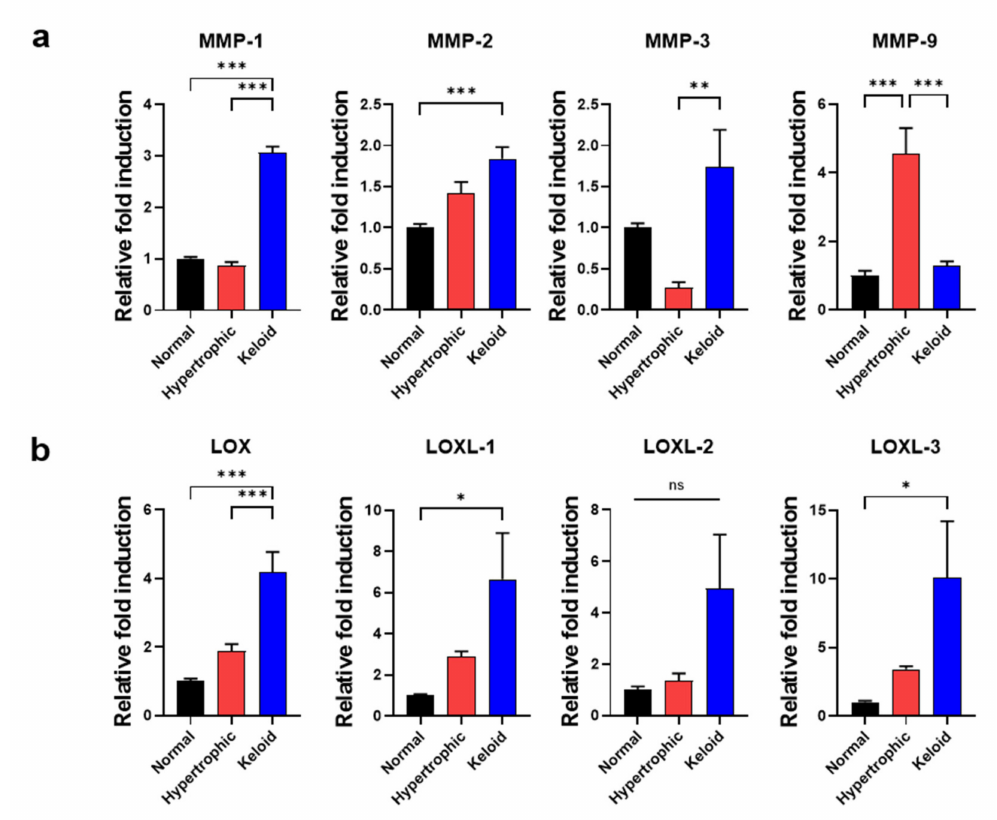
Figure 3. qPCR analysis of genes responsible for ECM remodeling and expressed in primary dermal fibroblasts from NHK patient-derived scar tissues. qPCR of ( a ) collagen-degrading MMPs and ( b ) collagen-cross-linking LOX and LOXLs . Data represented the mean ± SEM. * p < 0.05; ** p < 0.01; *** p <